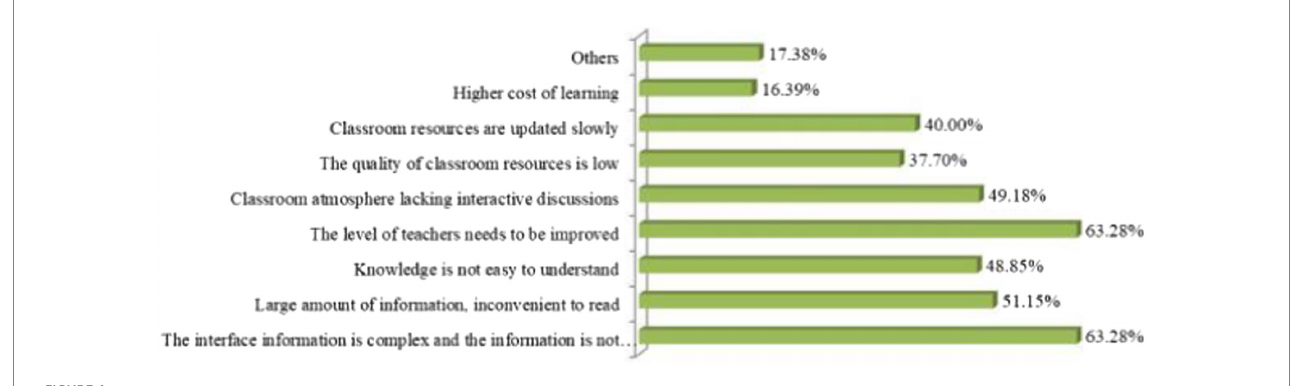
FIGURE 4 Statistical chart of problems with the online